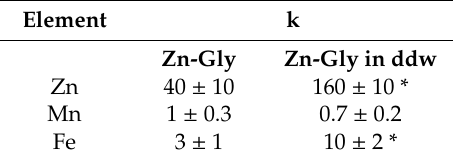
Table 3. Zinc accumulation factor (k) in C. fragrans leaves after incubation with zinc glycinate solutions in ordinary MilliQ water (D / H = 142 ppm) and (ddw) (D / H = 12 ppm). k = [Zn] after incubation with